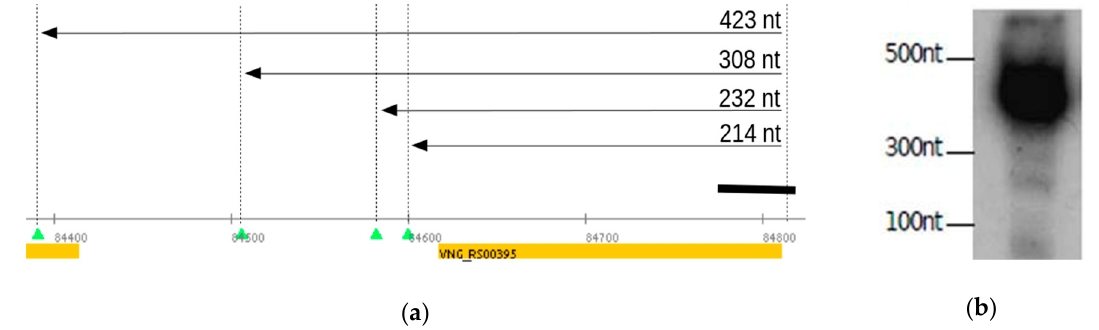
Figure 2. Experimental validation of predicted TPS using gene cspA1 (VNG_RS00395 locus ). ( a ) The consecutive TPS predict mRNAs of various sizes (arrows) from TSS to TPS_8361_1, TPS_8363_1, TPS_8365_1 and TPS_8366_1. Northern blot probe location is marked by the black rectangle. ( b ) Northern blot adapted from Figure 3 in [37].